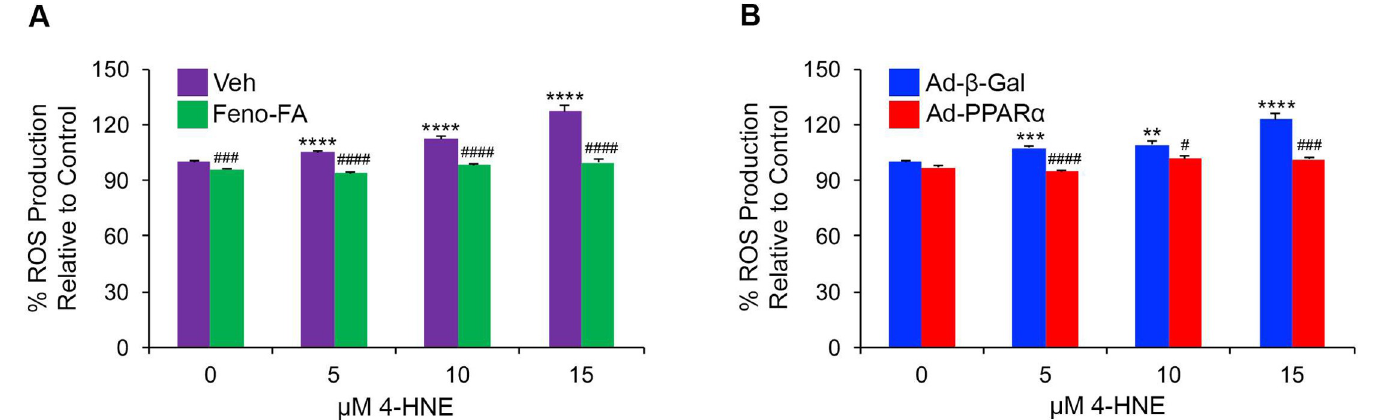
Fig 6. In vitro antioxidant effects of PPAR α activation and overexpression. (A) H 2 DCFDA ROS detection assay revealed that ROS production was increased in R28 cells treated with the indicated concentrations of 4-Hydroxynonenal (4-HNE) for one hour, and was decreased to baseline by pretreatment with 25 μ M fenofibric acid (Feno-FA) for 7 hours relative to vehicle (Veh, DMSO)-treated cells. Feno-FA modestly decreased ROS production in cells treated with 0 μ M HNE (n = 9 wells/group). (B) ROS assay revealed that ROS production was increased in 4-HNE-treated R28 cells, and was decreased by infection with PPAR α -expressing adenovirus (Ad-PPAR α , MOI 20) relative to infection with Beta-galactosidase-expressing adenovirus (Ad- β -Gal). Infection with Ad-PPAR α non-significantly decreased ROS production in cells treated with 0 μ M HNE (n = 6 wells/group). Data are representative of 2–3 independent experiments, and are expressed as mean ± SEM. �� p � 0.01; ��� p � 0.001; ���� p � 0.0001 relative to (A) Veh or (B) Ad- β -Gal-treated 0 μ M HNE groups. #p � 0.05; ##p � 0.01; ###p � 0.001; ####p � 0.0001 relative to cells treated with an equal concentration of HNE and (A) Veh or (B) Ad- β -Gal. One-way ANOVA with Tukey’s post-hoc comparison.